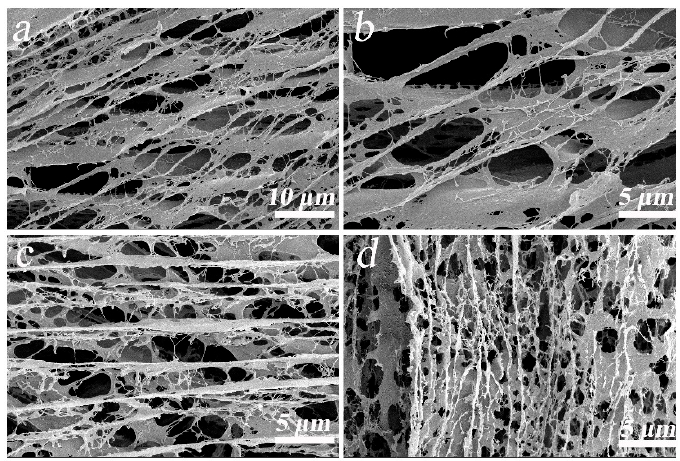
Figure 1. SEM micrographs of ( a , b ) PVA–GA–CNF ‐ 2 aerogel, ( c , d ) PVA–GA–CNF ‐ 4 and PVA–GA– CNF ‐ 5 aerogels, respectively .